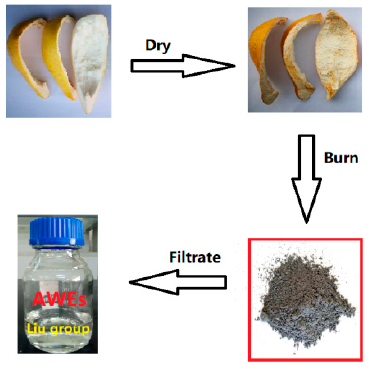
Figure 1. Preparation of AWEs.